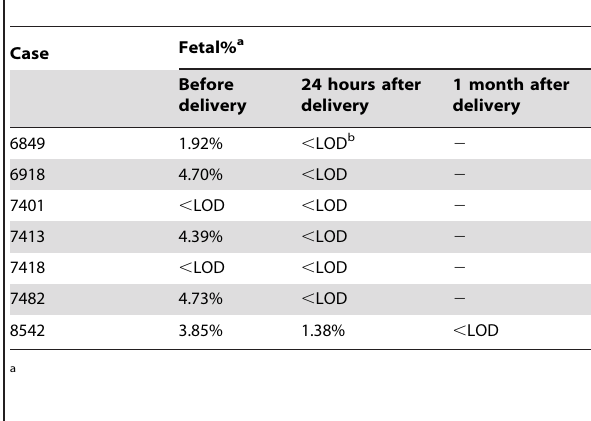
Table 2. Fractional fetal DNA concentrations in maternal urine as calculated by the SNP